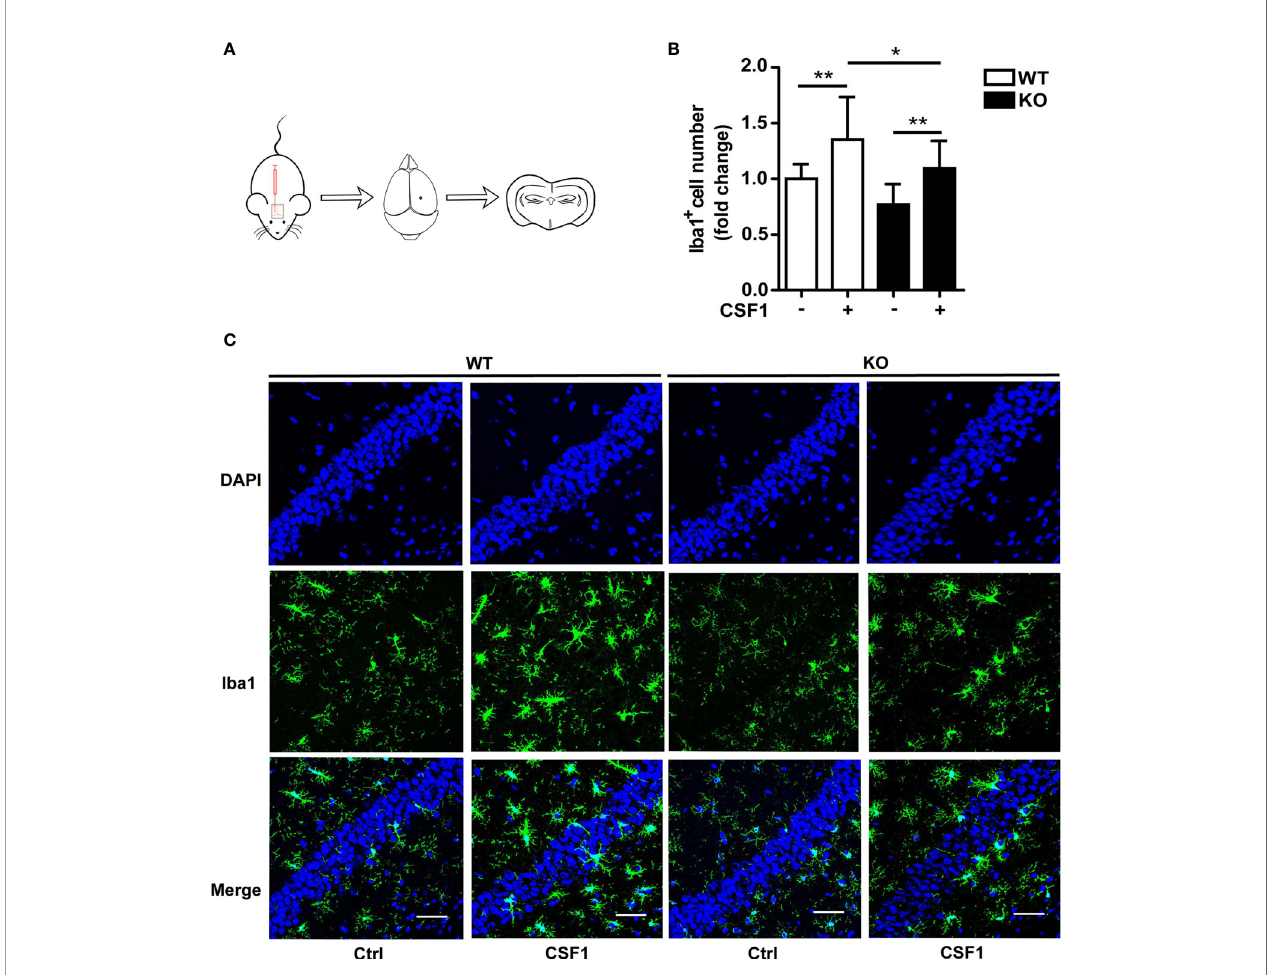
FIGURE 6 | CSF1 administration contributes to microglial survival in Trem2 KO mouse brain. (A) Schematic map of CSF1 intracerebroventricular injection in mouse brain. Two-month-old Trem2 KO and WT littermates were intralateroventricularly microinjected with 30 ng CSF1 daily for three days. Hippocampi and cortex from the left hemispheres of brains were dissected for protein and RNA extraction, and the right hemispheres of brains were embedded for cryostat sectioning and immuno fl uorescence. (B) Coronal sections from Trem2 KO or WT mouse brain were stained with Iba-1 (green) for microglia. Number of microglia double stained with DAPI (blue) and Iba1 (green) was quanti fi ed per HPF in Trem2 KO or WT mice. Microglia number response to CSF1 was assessed by quantifying the cell number ratio of CSF1 group to control group in WT or Trem2 KO brain. (C) Representative images of microglial immuno fl uorescent staining are shown. Two-way ANOVA with Tukey ’ s multiple comparison test. Data are plotted as mean ± SEM (n=3). * p <0.05; ** p <0.01. Scale bar, 50